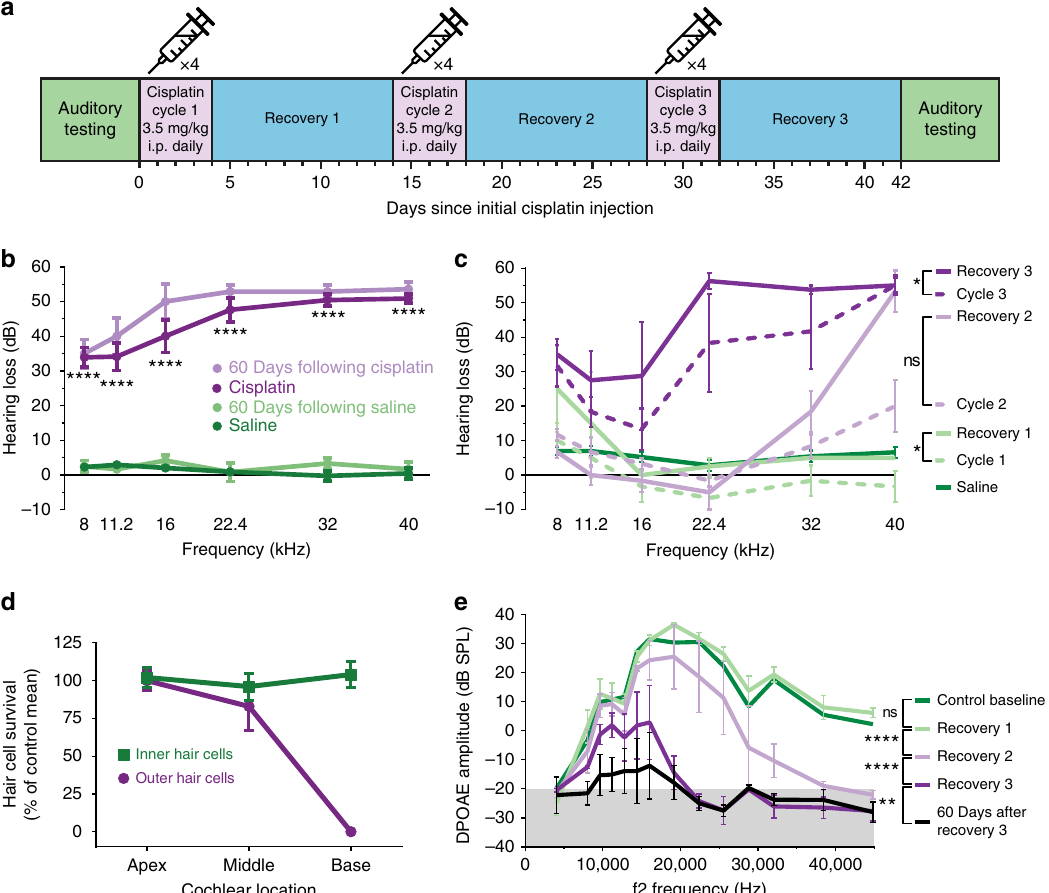
Fig. 1 A clinically relevant mouse model of cisplatin ototoxicity shows progressive, high-frequency hearing loss. a The three-cycle cisplatin regimen administered to CBA/CaJ mice. Each cycle consisted of 4 days of once-daily i.p. injections of cisplatin followed by 10 days of recovery. b Hearing